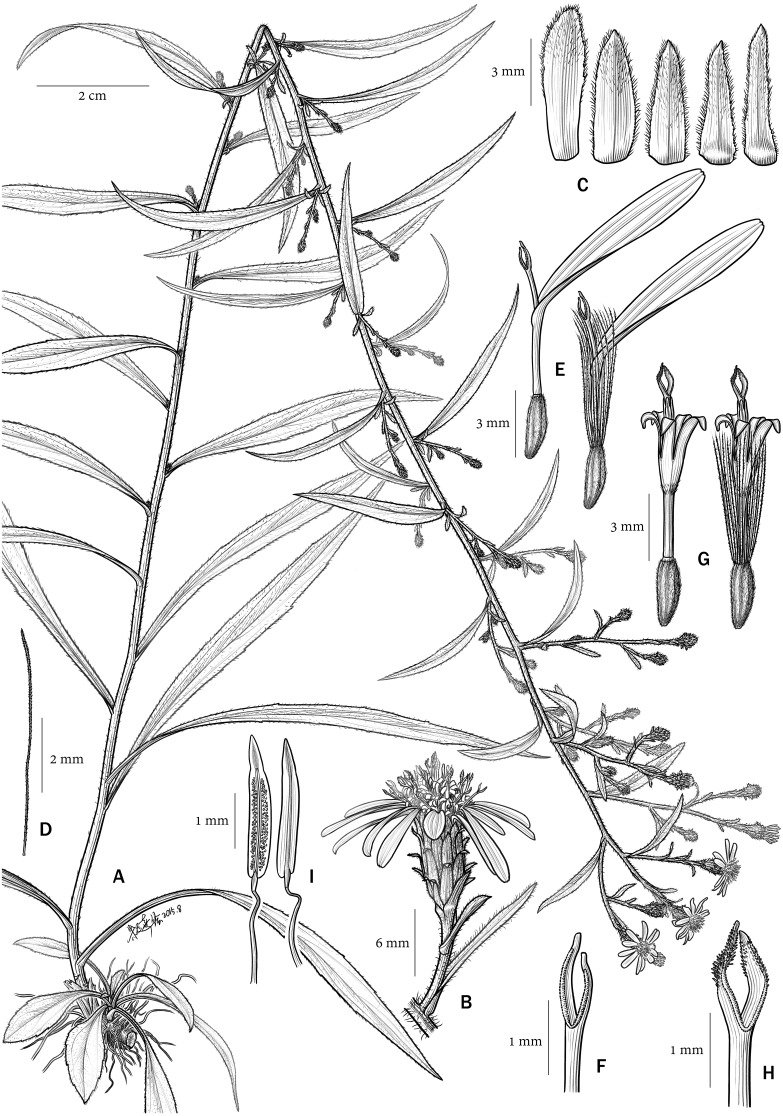
Aster tonglingensis.(A) habit; (B) capitula; (C) phyllaries; (D) bristle of pappus; (E) ray florets; (F) style branches of ray florets; (G) disc florets; (H) style branches of disc florets; (I) anthers.